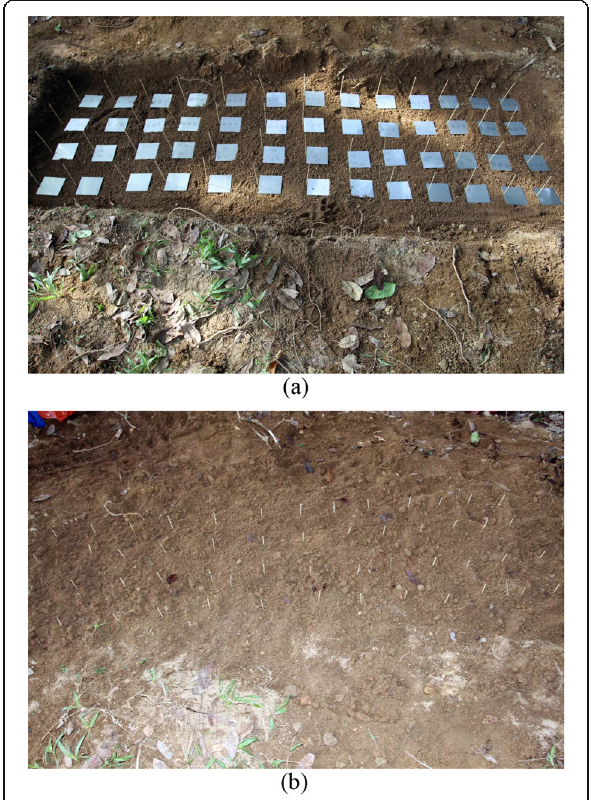
Fig. 4 Metal plates were placed on a the first layer of soil and covered with b 10-cm-thick second layer soil